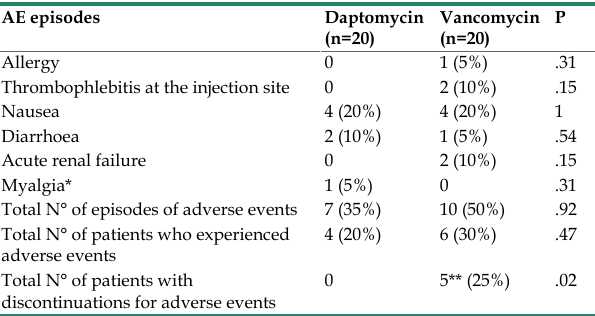
Table 3. Compared tolerance to antibiotic treatment of 40 patients treated empirically for either Vancomycin or